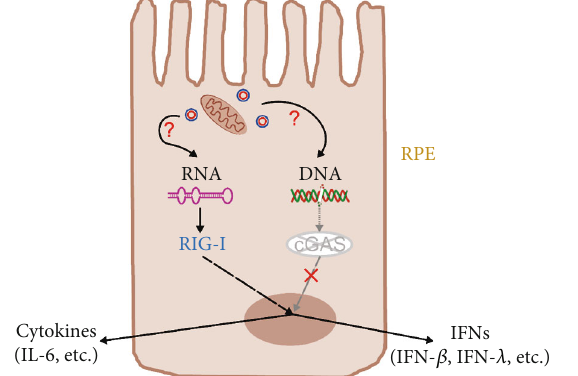
Figure 8: Schematic diagram for potential mechanism of intracellular nucleic acid sensing in